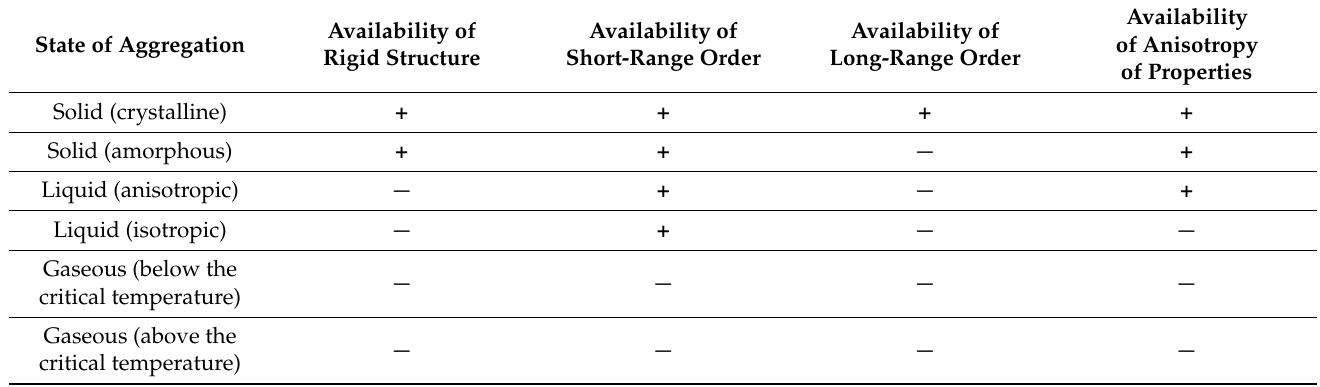
State of Aggregation